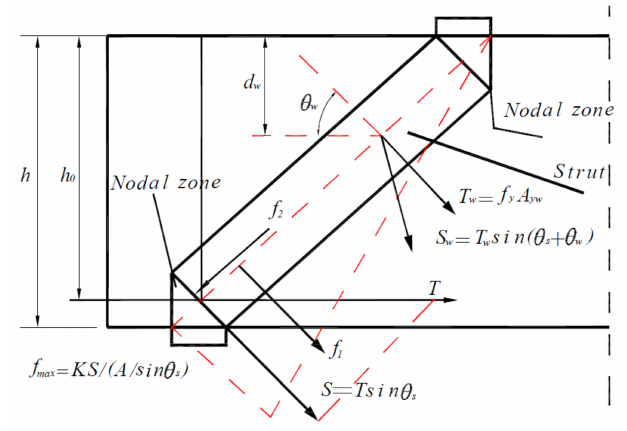
Figure 18. Equilibrium condition of the bottom nodal